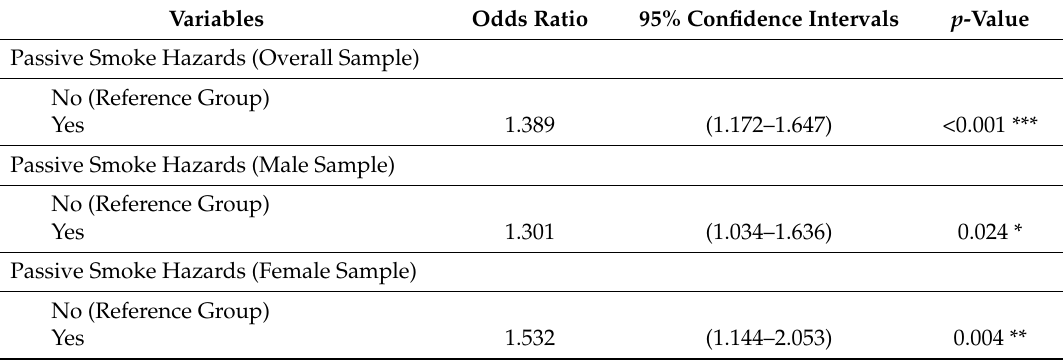
Table 6. Regression Analysis for Each Variable and Having